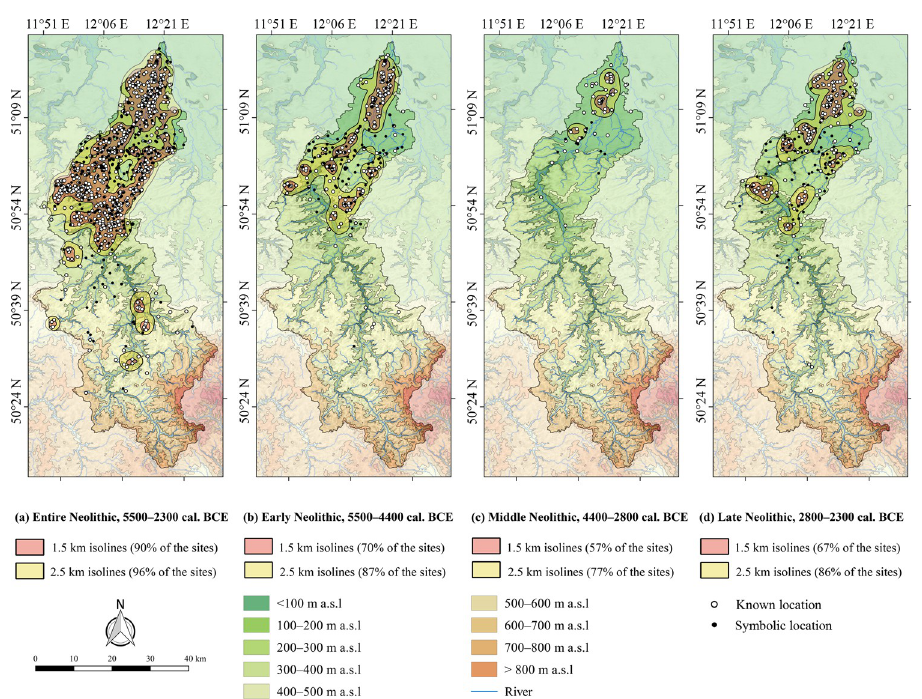
Fig 8. Neolithic site densities in the study area. (a) Entire Neolithic, (b) Early Neolithic, (c) Middle Neolithic and (d) Late Neolithic. Rivers were plotted according to the European Catchments and Rivers network system [60]. The topography is based on the SRTM 90 m Digital Elevation Database version 4.1 [61–63]. Topography and rivers have been modified according to older topographic maps (S2 Table). See Fig 2 for a location of the urban areas mentioned in the